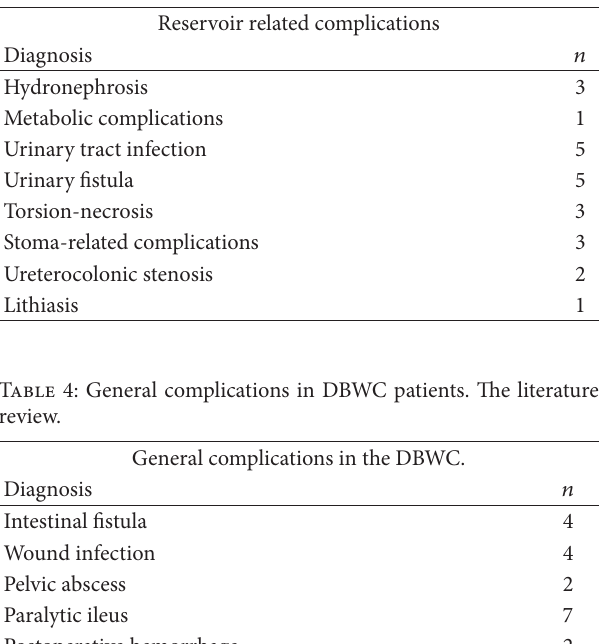
Table 2: Diagnosis in DBWC patients. The literature review. Table 3: Reservoir related complications. The literature review.